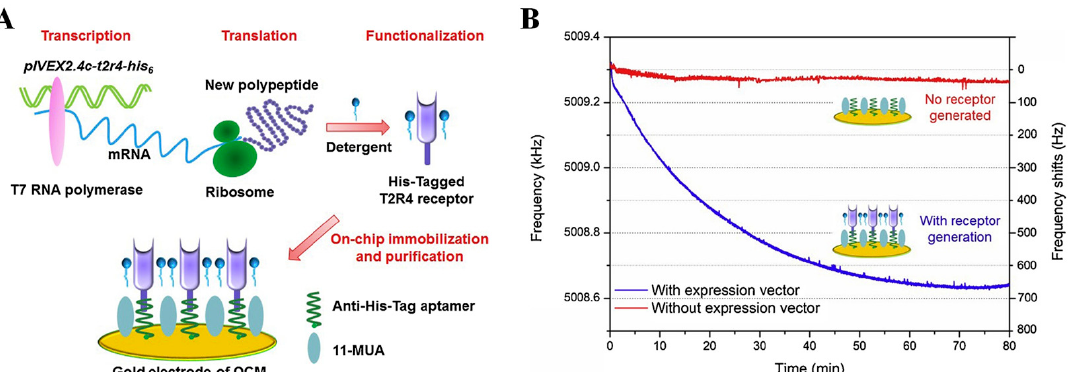
Figure 4. Biosensor constructed by modifying bitter taste receptors on QCM device. ( A ) Schematic design of in situ synthesis and purification steps of bitter taste receptors on QCM electrode; ( B ) the kinetics of bitter receptor proteins immobilization on the surface of QCM device via recording real-time crystal resonant frequency shifts. Reproduced from [117] with permission from